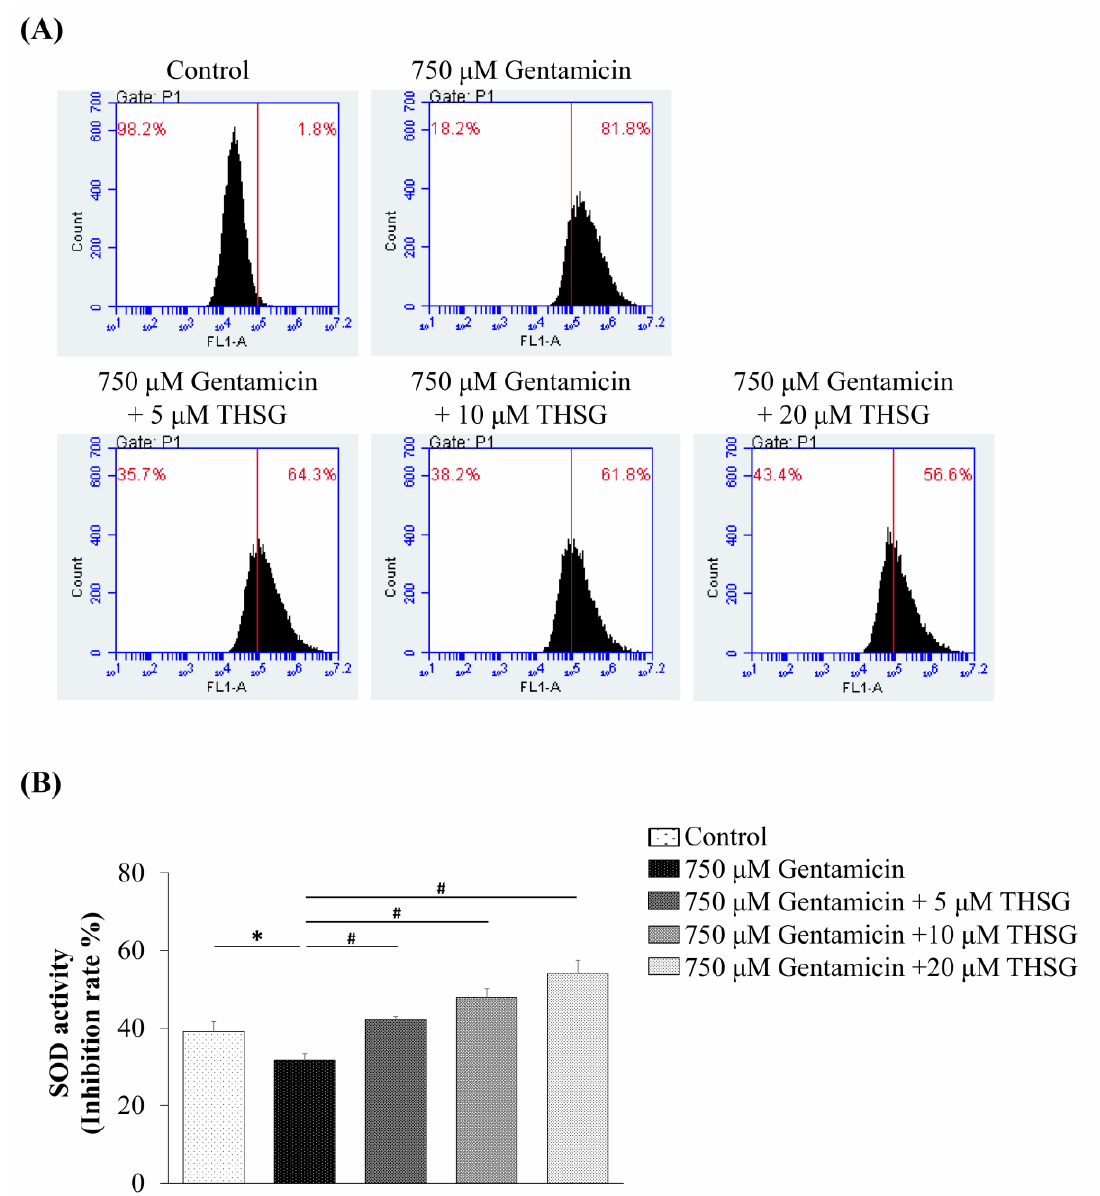
Figure 2. E ff ects of 2,3,4’,5-tetrahydroxystilbene-2- O - β - d -glucoside (THSG) on gentamicin-induced reactive oxygen species (ROS) generation and antioxidant enzyme activities in mouse cochlear UB / OC-2 cells. The cells were treated with various THSG concentrations followed by 750 µ M gentamicin to assess ( A ) ROS levels by flow cytometry using 2 (cid:48) ,7 (cid:48) -dichlorofluorescein diacetate (DCFDA) fluorescent dye and ( B ) the superoxide dismutase (SOD) activity. All data are expressed as means ± standard deviation from three independent experiments. * p < 0.05 vs. the control group; # p < 0.05 vs. the gentamicin-treated